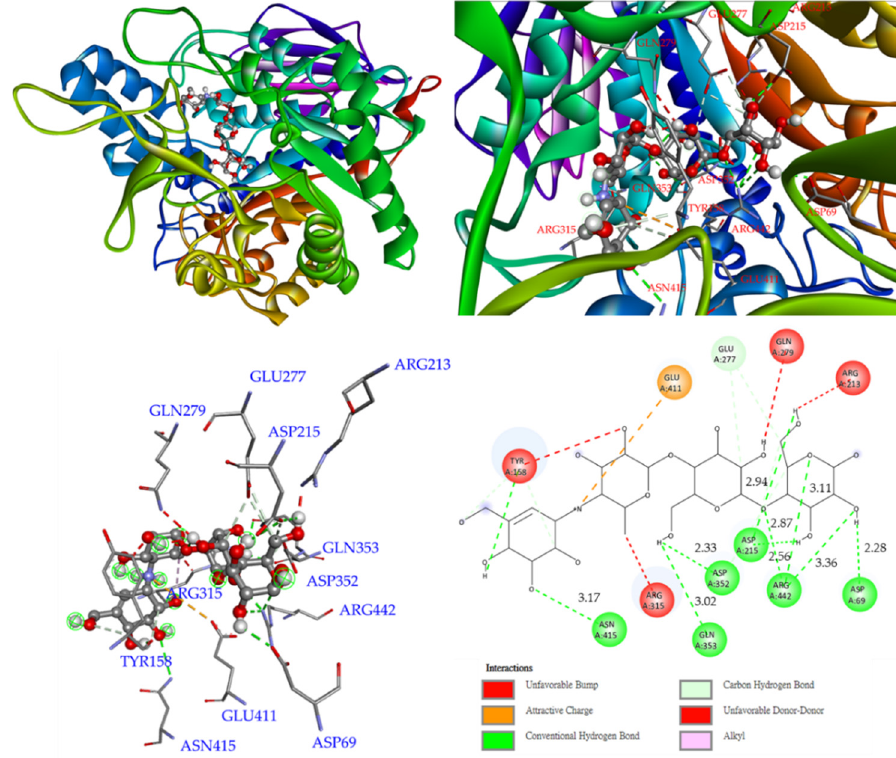
Figure 9. Interactions of acarbose with active sites of S. cerevisiae α -glucosidase.